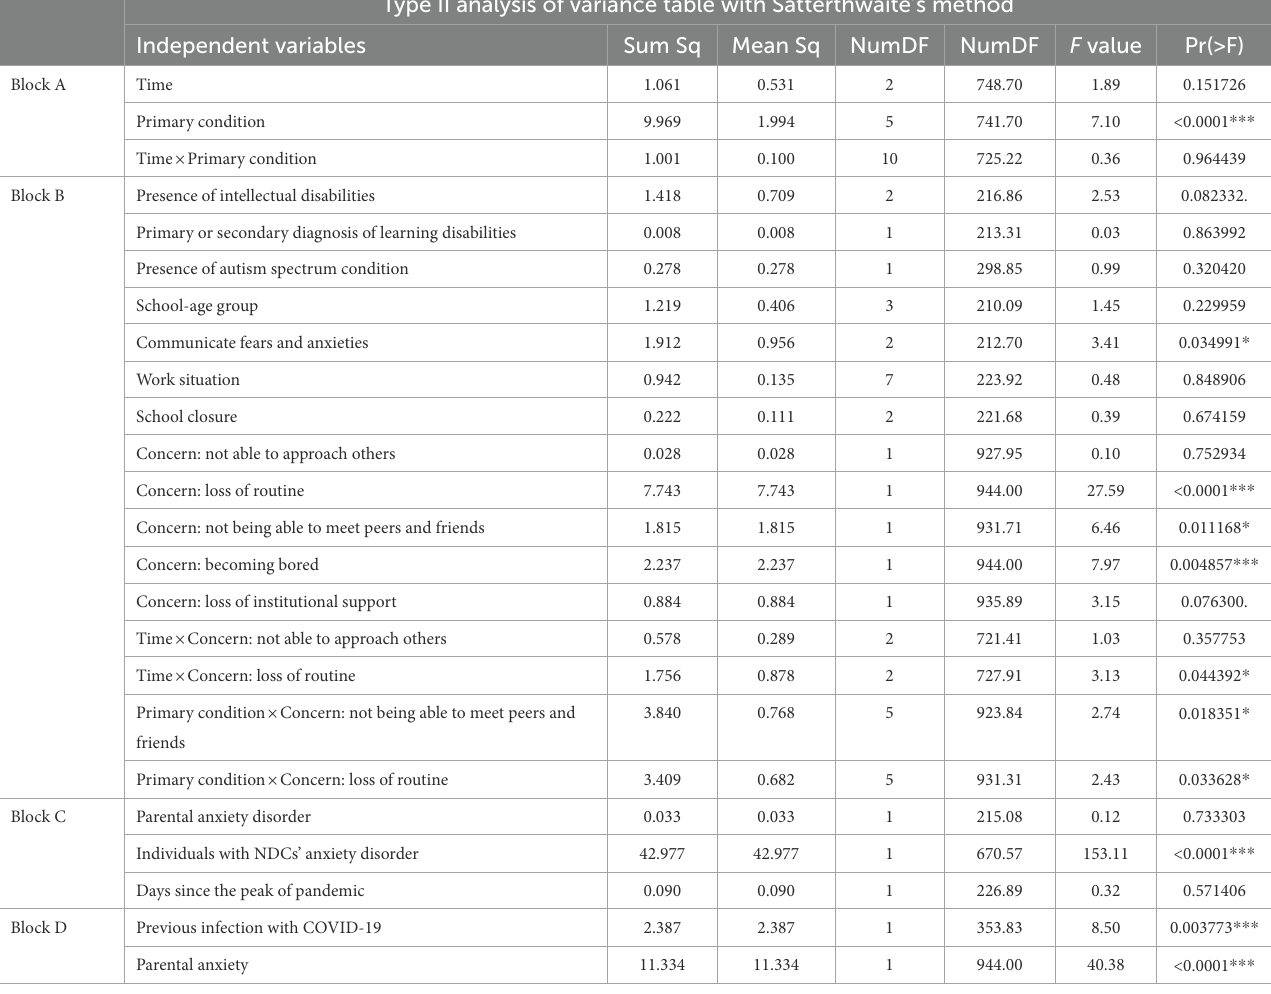
TABLE 2 Conditional multilevel analysis on Individuals with NDCs’ anxiety. Type II analysis of variance table with Satterthwaite’s method Independent